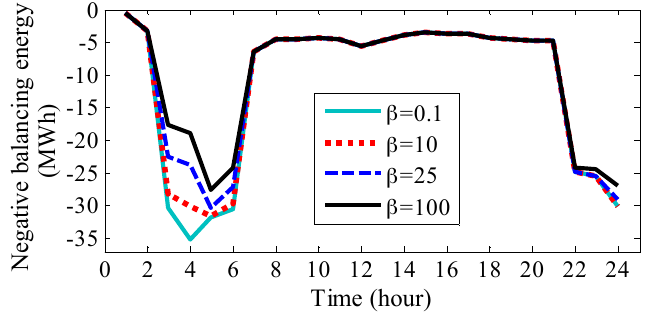
Figure 12. Expected negative balancing procurement for different levels of β .